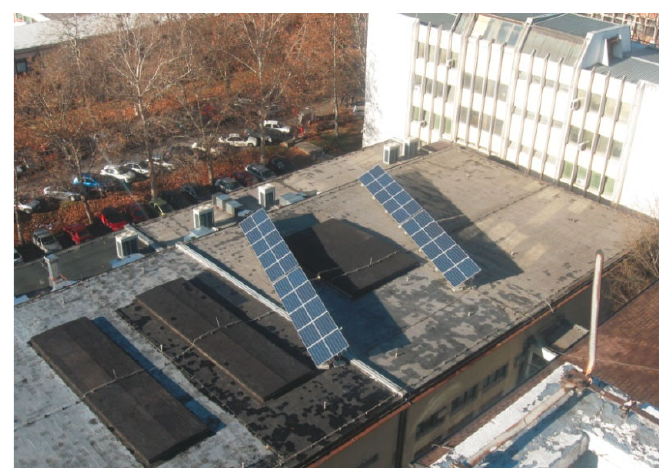
Figure 1. The overview of the PV power plant arrays from the FTS tower.